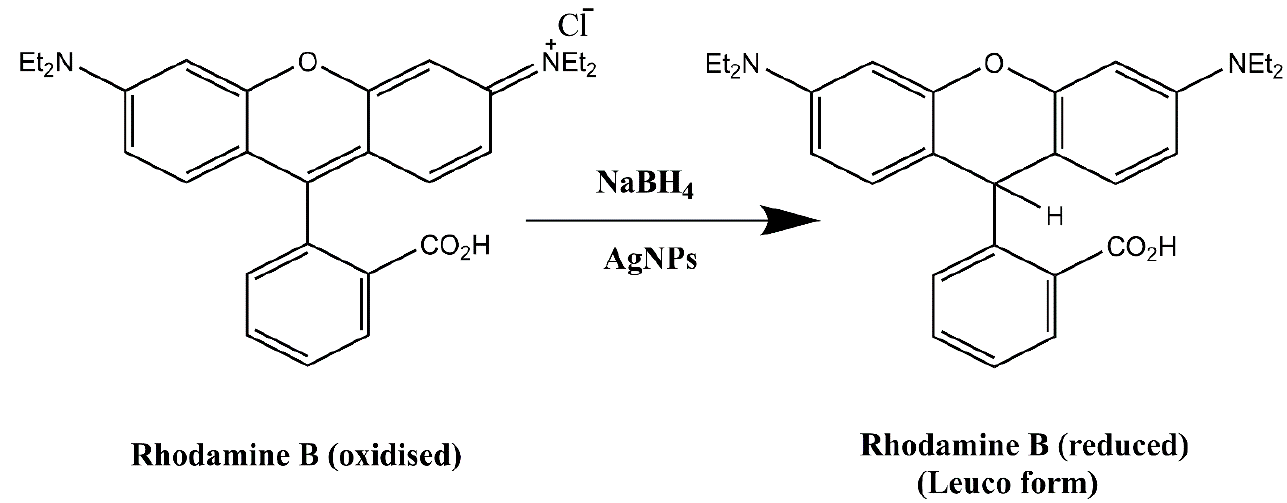
Figure 13. Schematic representation of reduction of Rhodamine B (RhB).